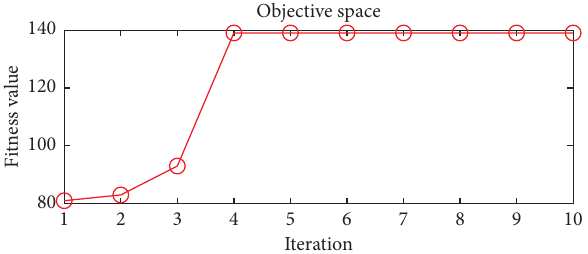
Figure 5: Simulated signals of case 1: PSO convergence curve based on IPAVMD.